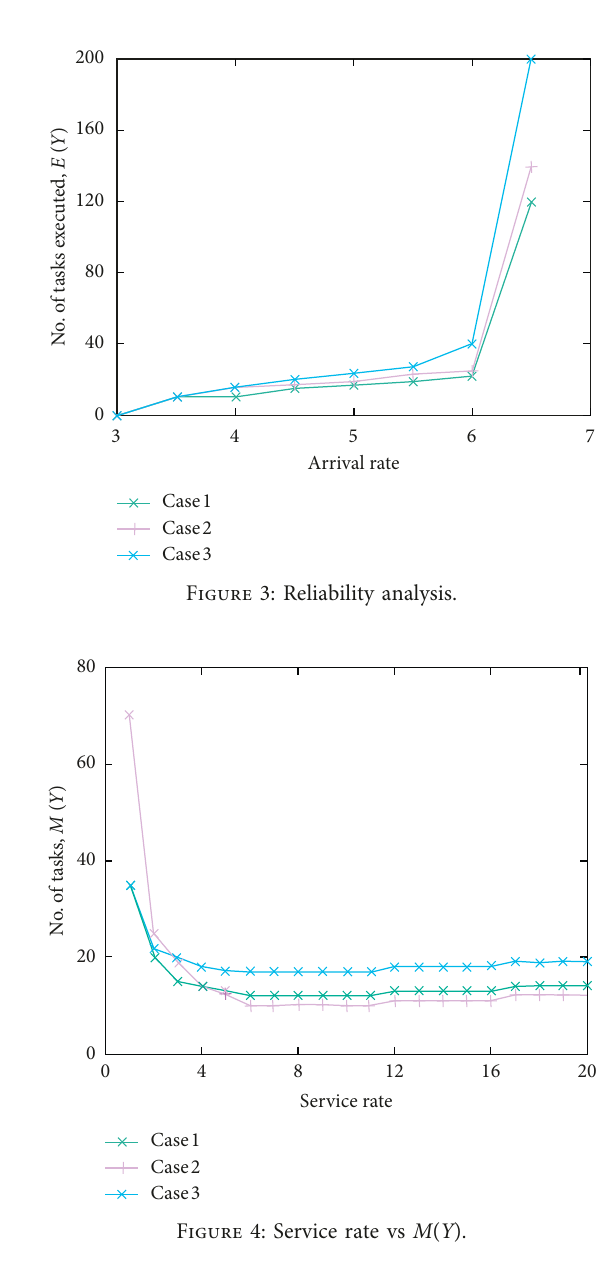
Figure 4: Service rate vs M ( Y